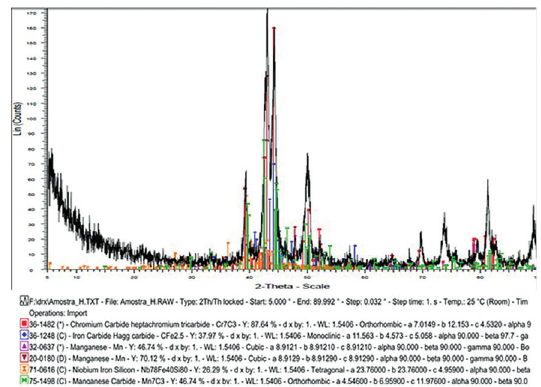
Figure 11: Microhardness, left Y axe, of the samples under the four different conditions and their corresponding Carbide volume fraction, right Y